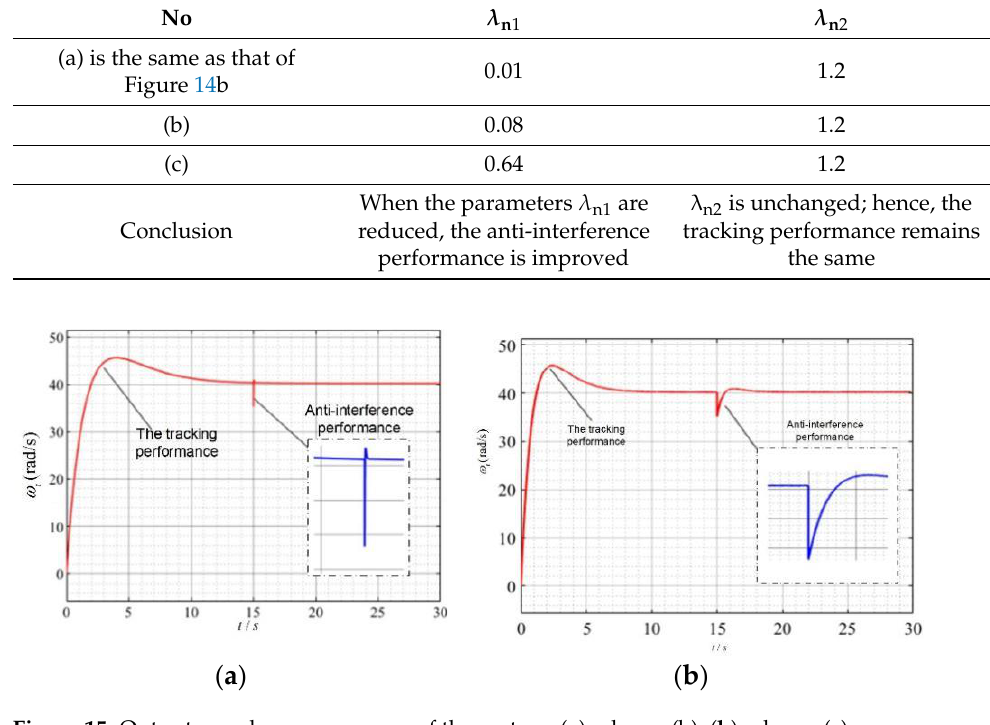
Figure 15. Output speed response curve of the system: ( a ) scheme (b); ( b ) scheme (c).